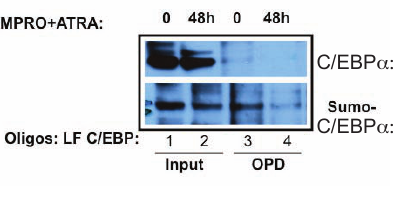
Figure 3. Oligonucleotide pulldown analy- sis of C/EBP a and sumoylated-C/EBP a during ATRA-induction of MPRO cells. Nuclear extracts prepared from uninduced (0) and ATRA-induced (48h) MPRO cells were incubated with biotinylated C/EBP site (LF/C/EBP) oligomers from the LF promoter and OPD conducted as above. The blot was probed sequentially with anti-C/EBP a (lanes 3 and 4, top panel) and anti-SUMO-1 (lanes 3 and 4, bottom panel) antibodies. Input samples are repre- sented in lanes 1 and 2 of the top (C/EBP a ) and bottom (SUMO-1) panels.